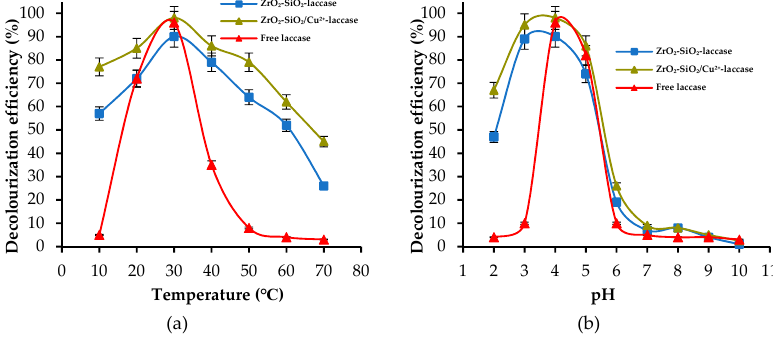
Figure 9. Effect of: ( a ) temperature and ( b ) pH of dye solution on decolorization efficiencies. Figure 9. E ff ect of: ( a ) temperature and ( b ) pH of dye solution on decolorization e ffi